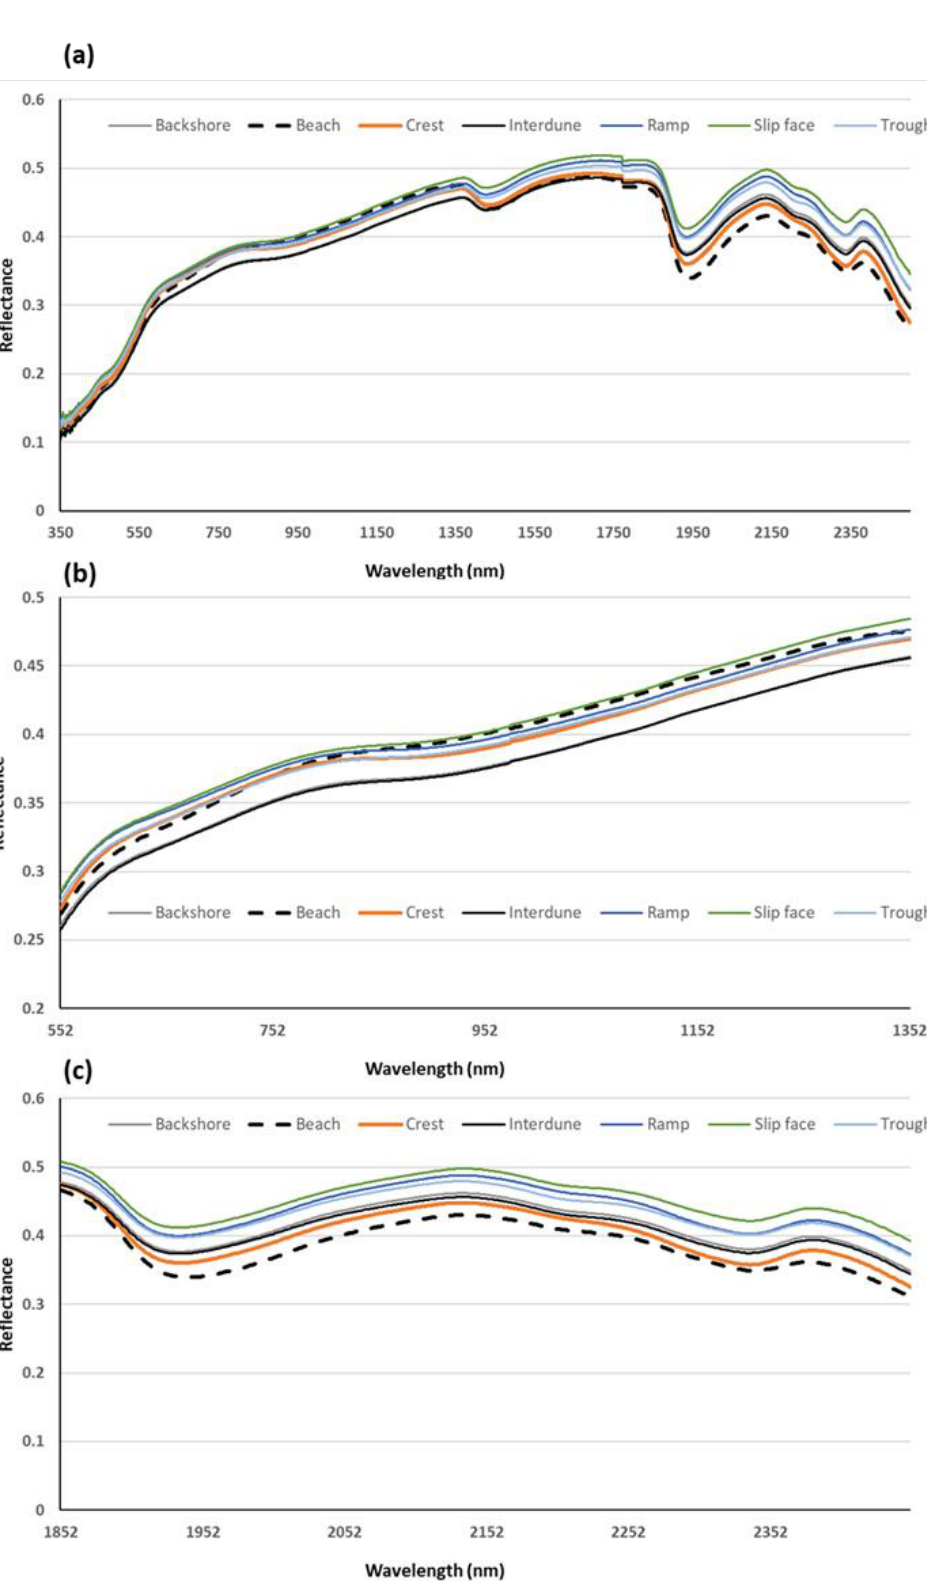
Figure 5. Results of spectral analysis of samples from different geomorphic positions at Oyster Bay. ( a ) Full average spectrum for samples from the different position; detailed results at ( b ) the VNIR (552–1352 nm) and ( c ) SWIR (1852–2450 nm) parts of the spectrum.